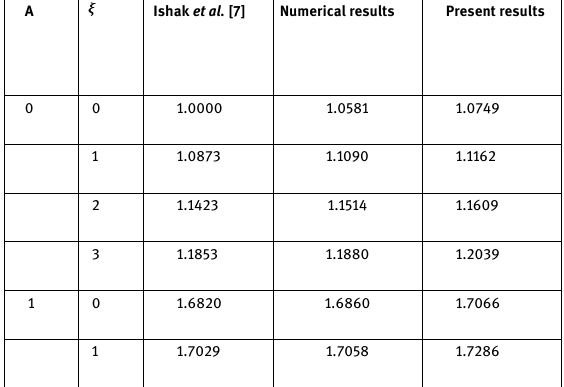
Table 3: Values of − θ (cid:48) (0) for β = 0, M = 0, λ = 0